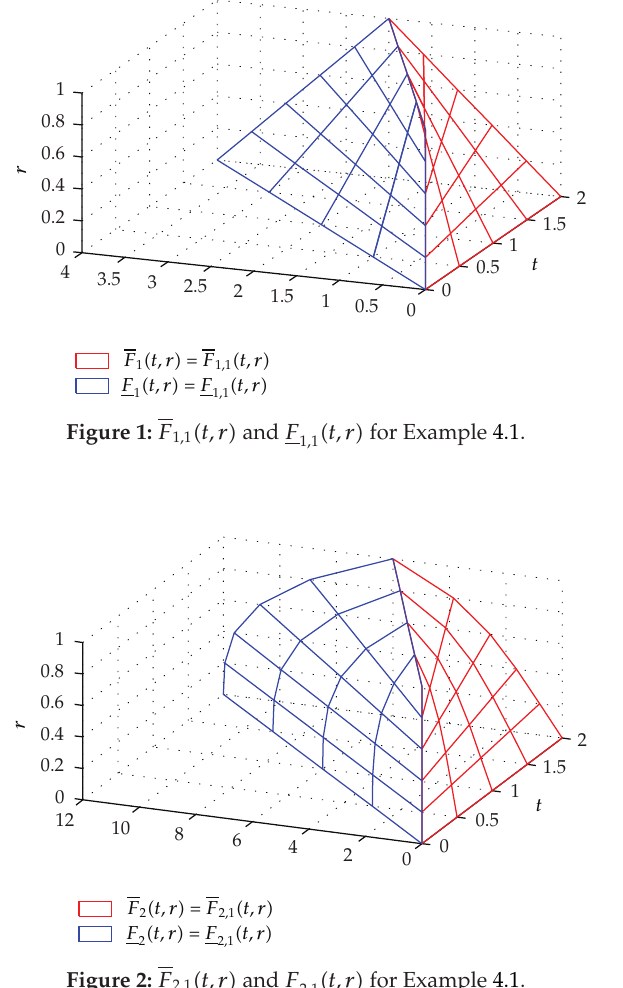
Figure 2: F 2 , 1 (cid:6) t,r (cid:7) and F